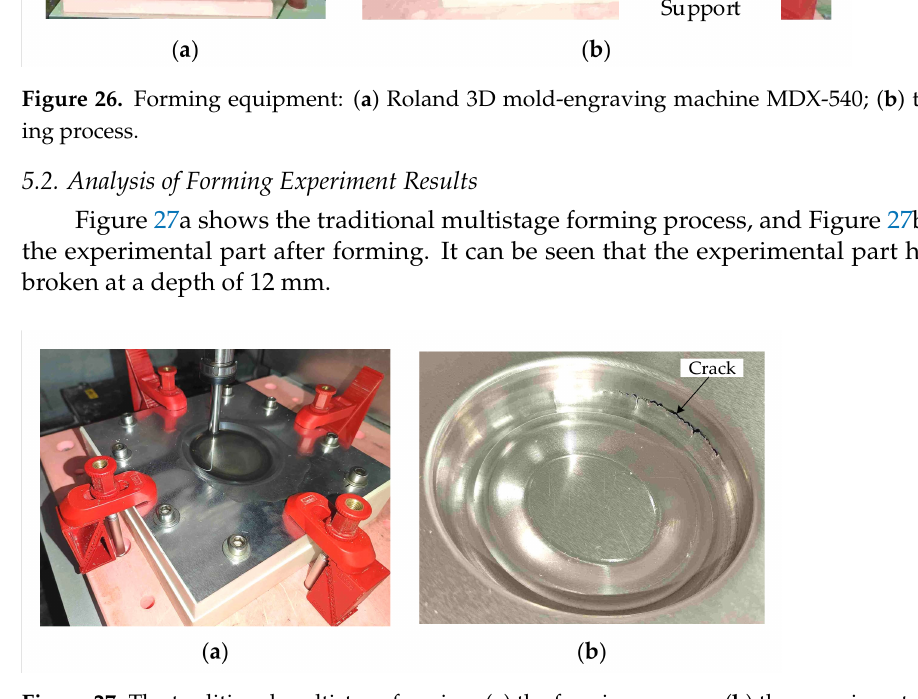
Figure 27. The traditional multistage forming: ( a ) the forming process; ( b ) the experimental